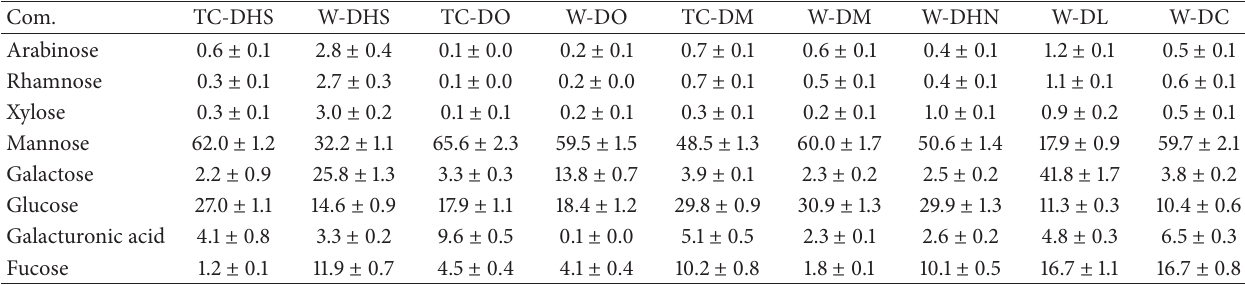
Table 3: Monosaccharide compositions and contents (%) of the polysaccharides from the nine Dendrobium samples detected by GC-MS analysis of their TMS